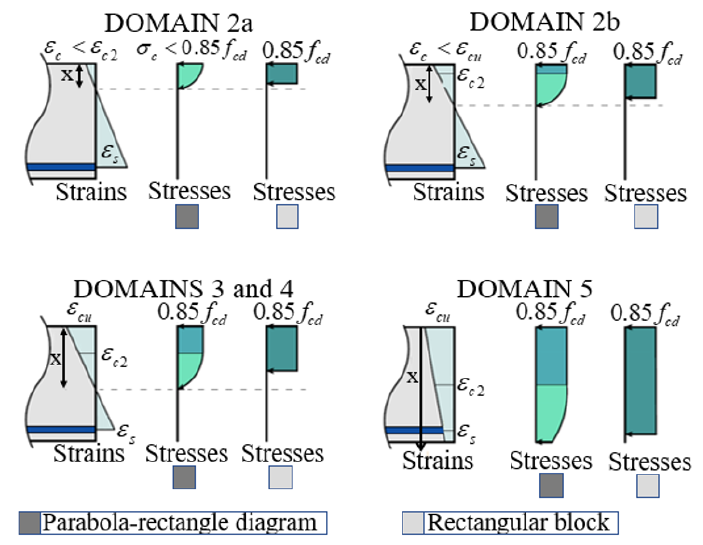
Figure 4. Concrete strains and stresses in the ultimate limit state.